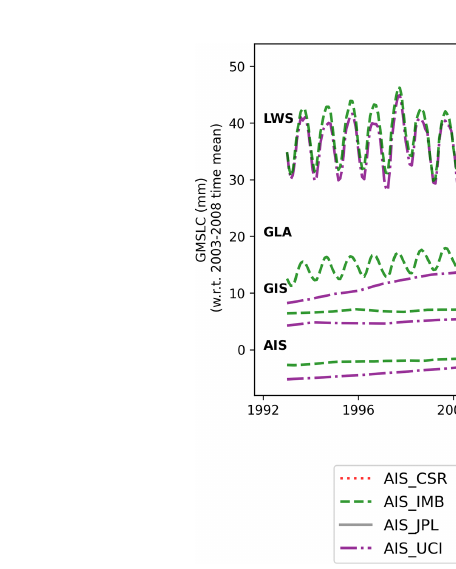
Figure 1. Global mean barystatic sea-level change time series. Different components are vertically offset for visualization